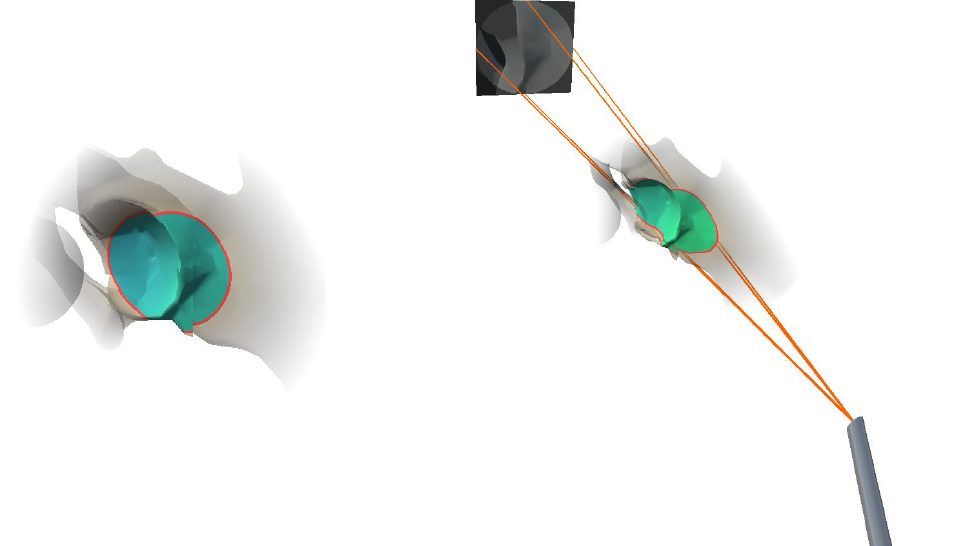
Figure 3. Visualization of the augmented target anatomy ( left ). The red outline marks the anatomical area in focus, while colorization encodes the distance to the endoscope. The anatomical visualization is combined with the frustum visualization ( right